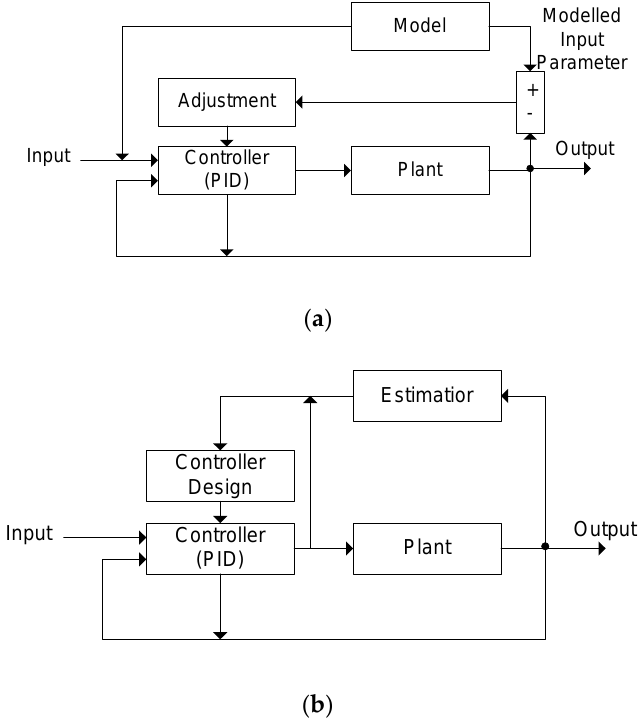
Figure 12. The block representation of ( a ) direct adaptive control [115] ( b ) indirect adaptive control [115].